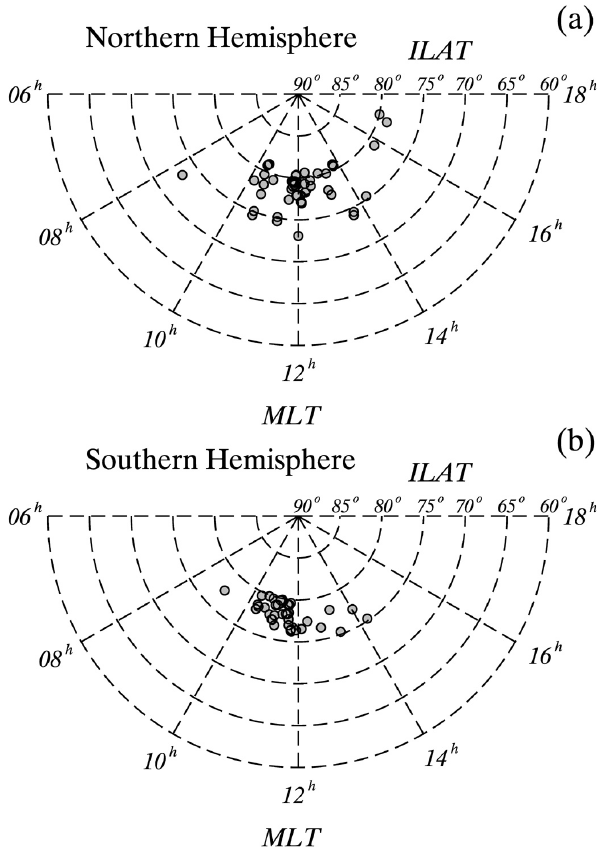
Fig. 2. Location of all the cusp crossings as a function of MLT and ILAT, (a) for the Northern Hemisphere, and (b) for the Southern